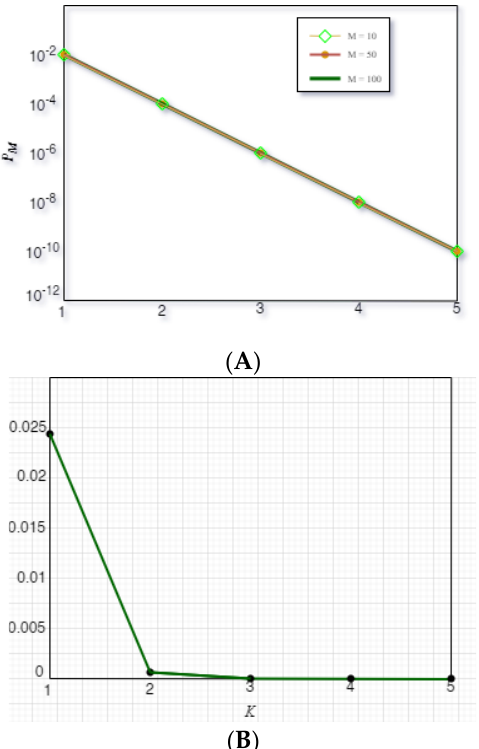
Figure 15. ( A ) Simulation; ( B ) Numerical.